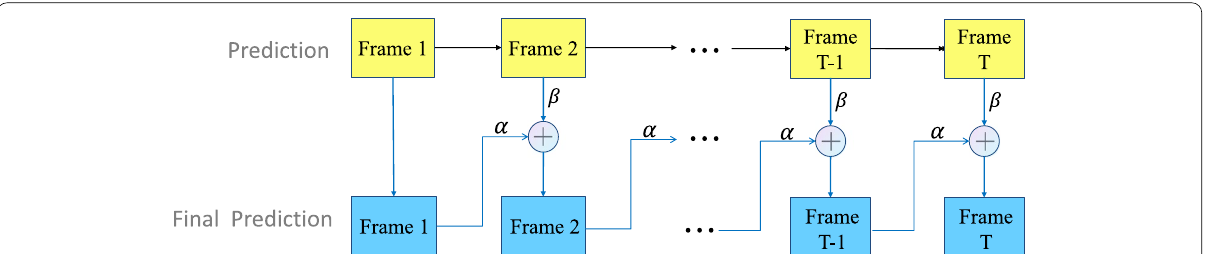
Fig. 4 The prediction revision module. The first line of ‘prediction’ is the result directly predicted by the network, while the second line is the “final prediction.” From the second frame, the current ‘prediction’ result is fused with the “final prediction” result of the previous frames and then calculated as the final prediction for the current